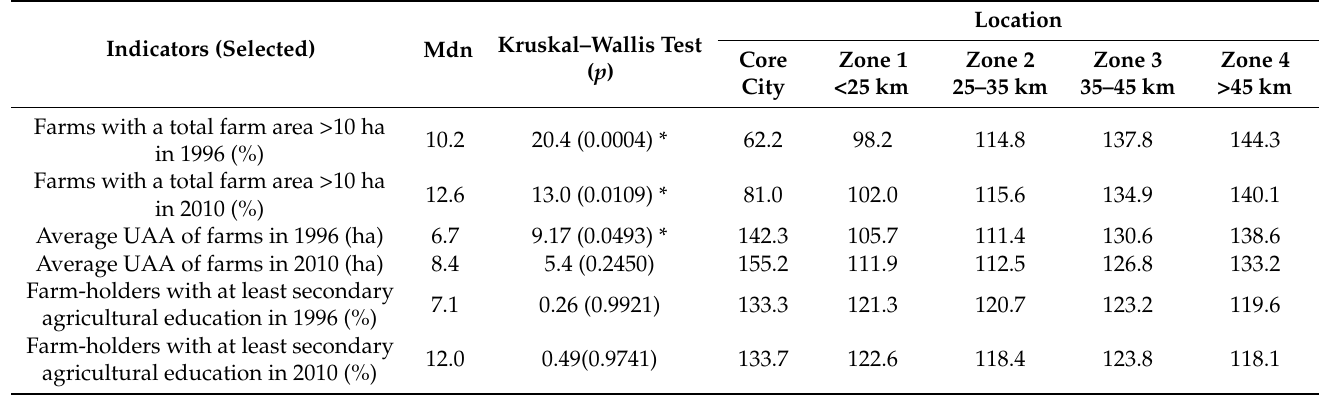
Table 5. Median and medium rank size of selected variables building factor F1, depending on the location.